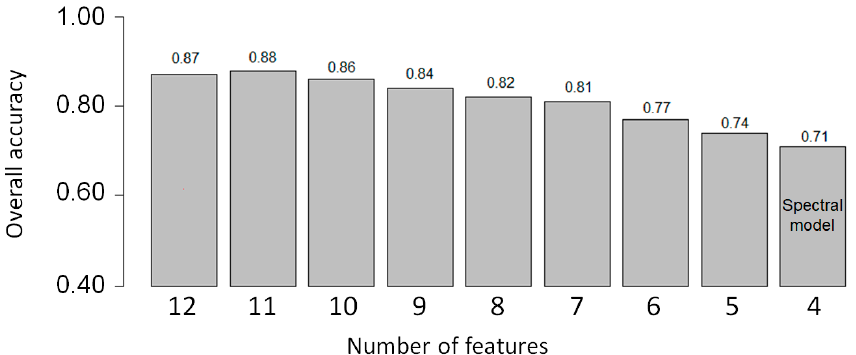
Figure 9. Recursive pruning of the best model (Spectral + 9 × 9 GLCM features). The complete model contains 11 features. These features were recursively eliminated according to the Boruta ranking without eliminating spectral characteristics. The last pruning contains only the 4 spectral